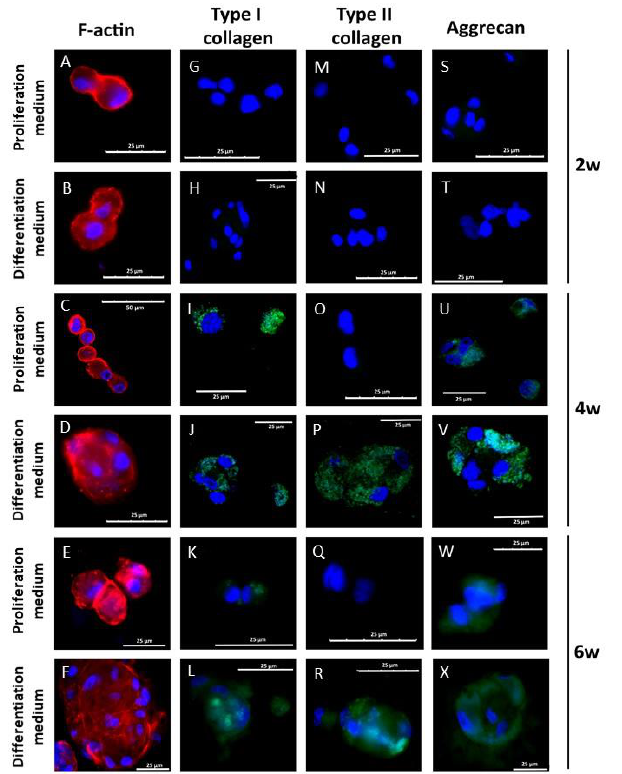
Figure 7. hDPSCs differentiation in alginate agarose gels. 2 × 10 6 cells/ml were encapsulated in 3% alginate 1% agarose hydrogels and cultured with proliferation or differentiation medium for 2, 4 and 6 weeks. F-actin organization was eval- uated by fluorescence microscopy using rhodamine-phalloidine ( A – F ). Type I ( G – L ) and II ( M – R ) collagen as well as aggrecan ( S – X ) were evaluated by immunofluorescence. Nuclei were staining with DAPI. Images are representative of n = 5 different